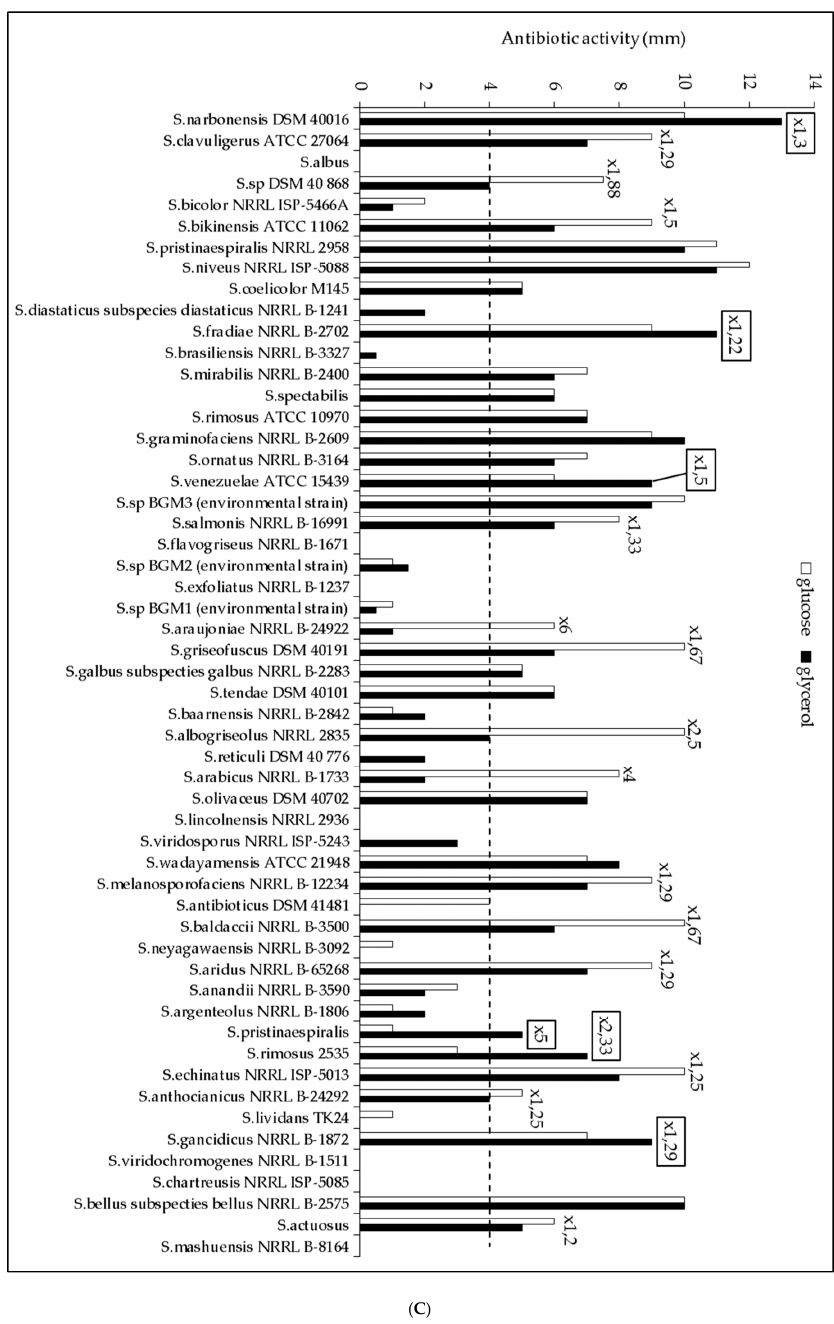
Figure 1. Total lipid / fatty methyl ester (FAME) content and antibiotic activity of Streptomyces strains. The strains were grown on modified solid R2YE limited in phosphate for 72 h at 28 ◦ C with either glucose (white histograms) or glycerol (black histograms) as the main carbon source. Their total lipid / FAME content, determined with FTIRS, was ranked according to their increasing lipid / FAME content upon growth on ( A ) glucose or on ( B ) glycerol. Significant di ff erences in lipid content between glucose- and glycerol-grown cultures are represented by an asterisk (ANOVA, *** = p < 0.001; ** = p < 0.01; * = p < 0.05). ( C ) Antibiotic activity of Streptomyces strains determined by the measurement of the diameters of the zones of growth inhibition of Micrococcus luteus around four agar plugs of each Streptomyces culture. Fold changes in antibiotic activity ( > 1.2 fold) between glucose and glycerol for inhibition zones > 4mm are shown above the histograms. The fold changes of the six cases where antibiotic activity was higher on glycerol than on glucose are